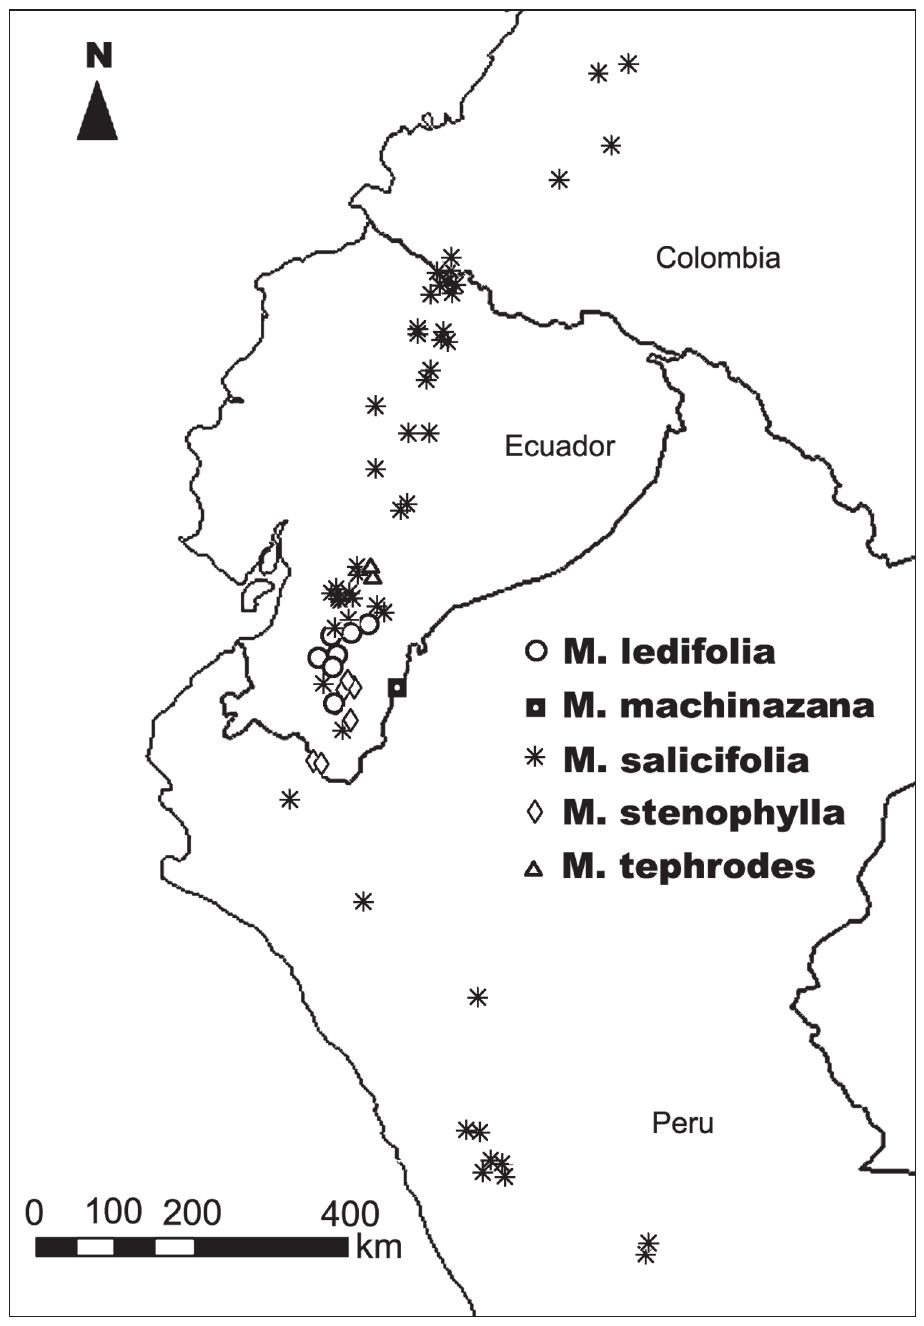
Figure 6. Distribution map of Miconia ledifolia, M. machinazana, M. salicifolia (partial) , M. stenophylla, and M. tephrodes (See Table 1; for complete species distribution see